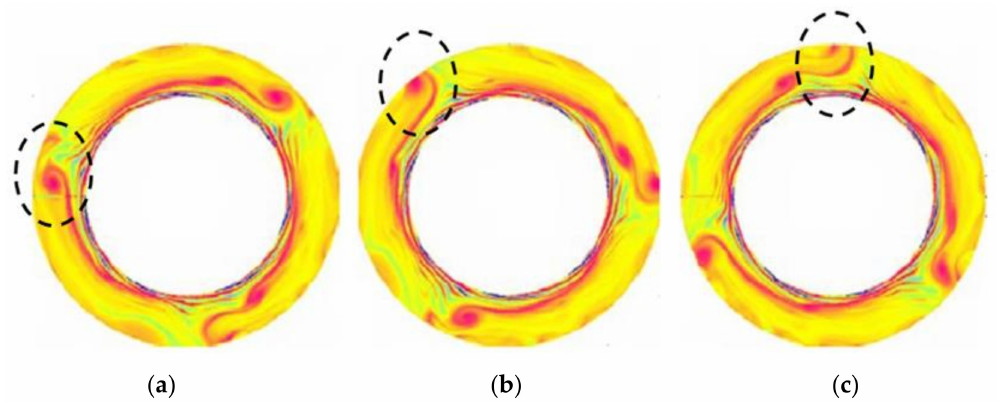
Figure4. Transportation of the inlet vortex (extracted from Dazin et al. [30]): ( a ) t / t ref = 65.7; ( b ) t / t ref = 66.9; ( c ) t / t ref = 68.1.